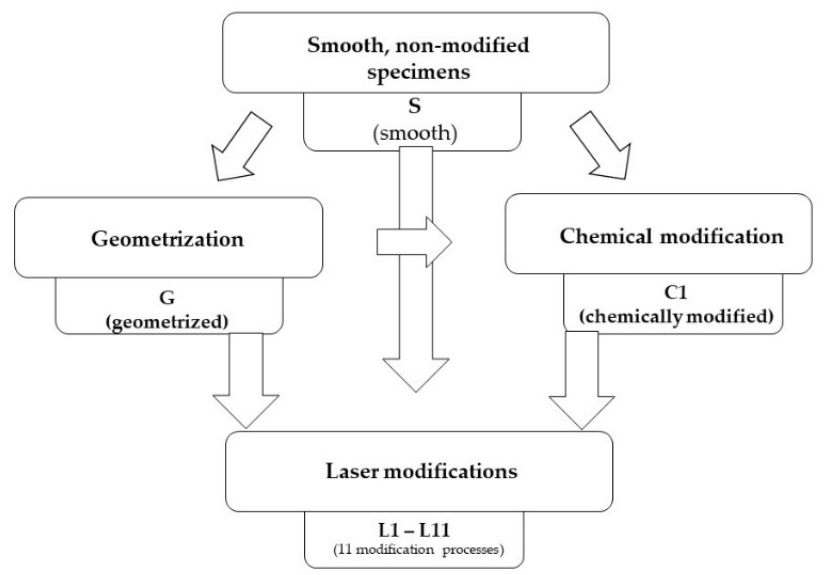
Figure 2. Modification procedure.